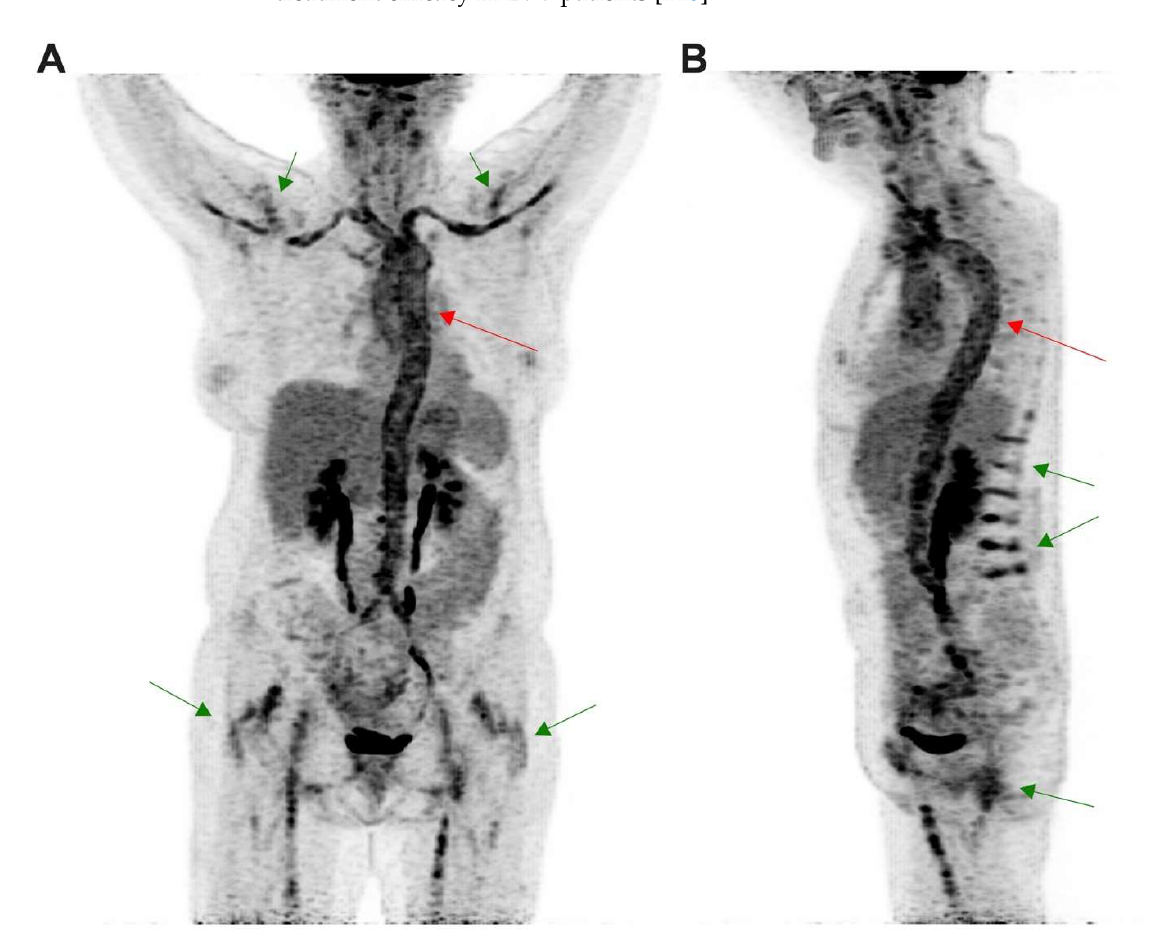
Figure 4. [ 18 F]FDG PET/CT was performed in a 64 year old patient for a suspicion of giant cell arteritis. ( A ) Coronal and ( B ) sagittal images obtained from maximal intensity projection revealed intense uptake in the vascular wall from the whole aorta (red arrows) extended to axillary and femoral vessels, above the liver uptake, corresponding to an LVV. LVV was associated with patterns of polymyalgia rheumatica (green arrows) corresponding to interspinous bursitis ( B ; green arrow) and also inflammation in hips and shoulders joints ( A ; green arrow).